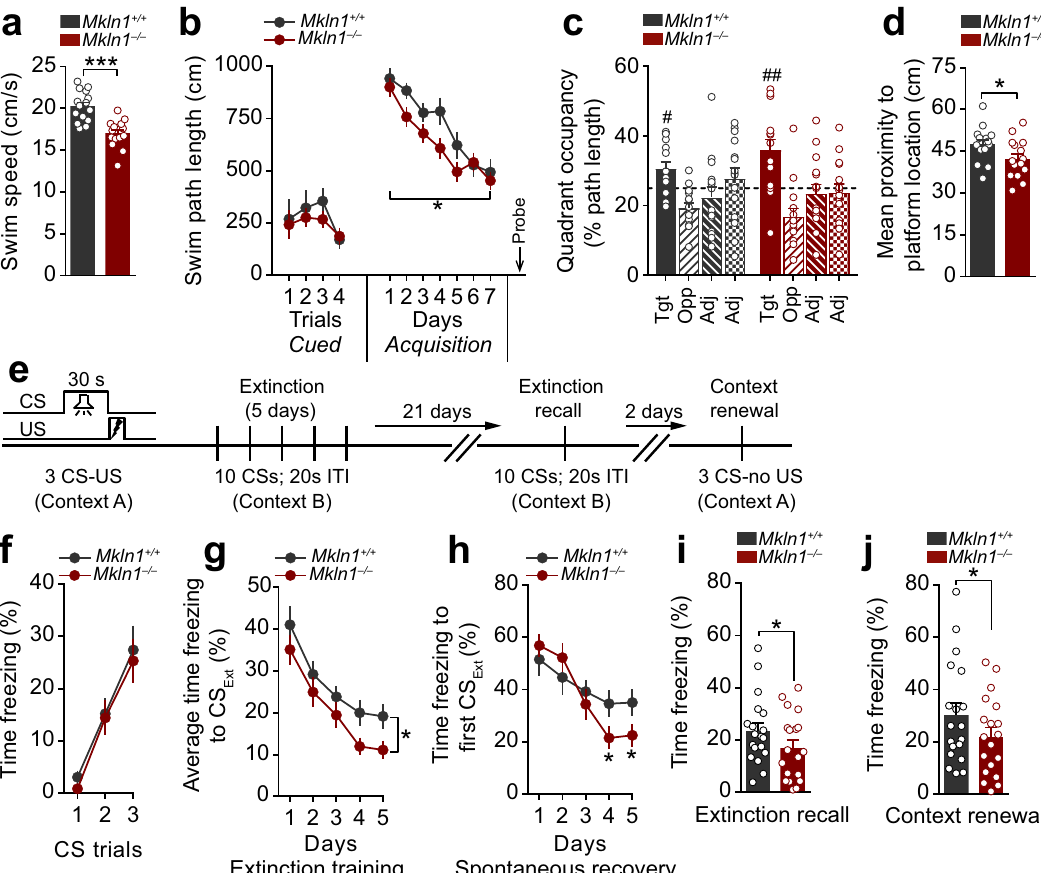
Fig. 3 Mkln1-null mice exhibit enhanced spatial reference memory retention and greater fear extinction recall. a Signi fi cantly lower swim speed in Mkln1 – / – mice during water maze training (genotype: F (1,26) = 24.91, P < 0.0001). b Mice from both genotype groups demonstrate equal distance (path length) to reach a visible (Cued) escape platform. Training in the hidden platform task (Acquisition) to assess spatial reference memory revealed clear learning across 7 days of training in both genotype groups (days: F (6,156) = 20.94, P < 0.0001). However, swim path length was signi fi cantly shorter in Mkln1 – / – mice compared with the Mkln1 + / + control group (genotype: F (1,26) = 6.97, P < 0.05). c The proportion of swim track (% path length in individual quadrants during the probe trial. Both genotype groups showed signi fi cant spatial bias for the target quadrant (quadrant: F (3,78) = 8.86, P < 0.0001) that different signi fi cantly from chance as depicted by the dashed line (one-sample t-test against 25% random search: # P < 0.05, ## P < 0.01). d Proximity to the escape platform throughout the probe trial. This is indexed as the mean cumulative distance between the mouse and target center, which was signi fi cantly shorter for Mkln1 – / – mice relative to Mkln1 + / + controls (genotype: F (1,26) = 5.87, P < 0.05). e Scheme depicting the cued fear conditioning paradigm to examine associative fear learning and extinction of fear memories. Fear acquisition in context A; extinction training and recall in a novel and neutral context B; test for fear renewal in context A. f Both genotypes show equivalent freezing levels to the discrete CS-tone during conditioned fear acquisition. g Percent time freezing to non-reinforced trials during extinction training. Mkln1 – / – mice showed signi fi cantly lower freezing responses across fi ve extinction sessions compared with Mkln1 + / + mice (genotype: F (1,34) = 5.27, P < 0.05). h Assessment of freezing responses at the outset of each extinction session ( fi rst CS trial) shows signi fi cant attenuation of spontaneous fear recovery in Mkln1 – / – mice with continued extinction training (days × genotype: F (4,136) = 4.28, P < 0.01) followed by Bonferroni post hoc test for pairwise comparisons (* P < 0.05). i Enhanced long-term extinction memory recall in Mkln1 – / – mice compared with Mkln1 + / + mice (genotype: F (1,34) = 5.29, P < 0.05). j Return of fear through contextual renewal was signi fi cantly lower in Mkln1 – / – mice (genotype: F (1,34) = 4.54, P < 0.05). Data related to ( a – d ) ( Mkln1 + / + ( N = 15: M = 8, F = 7) ; Mkln1 – / – ( N = 15: M = 8, F = 7); e – j ( Mkln1 + / + ( N = 19: M = 8, F = 11) ; Mkln1 – / – ( N = 19: M = 7, F = 12). Data are presented as means ± and the amygdala (Amy) and between the caudate – putamen (CPu) and medial septum (MS) in Mkln1 – / – mice (Fig. 4b). Further ana- lyses of homotopic interhemispheric connectivity indicated that Mkln1 – / – mice generally lack functional synchronization with the contralateral side (Supplementary Fig. 3b). Given that the neural microstructure state may in fl uence functional coupling, we investigated brain water diffusivity with diffusion tensor imaging (DTI), which permits identi fi cation of white and gray matter integrity. Assessment of diffusion tensor derived indices (fractional anisotropy, FA and mean diffusivity, MD) yielded signi fi cantly reduced FA in the right CPu (Supplementary Fig. 3c), suggesting diminished structural